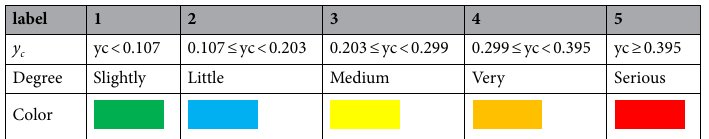
Table 4. Node label category and corresponding description.